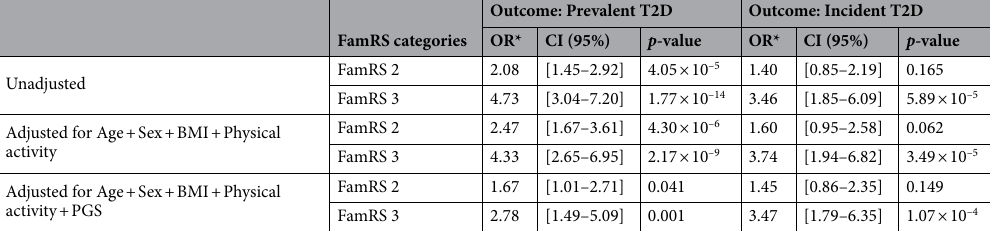
Table 4. Results of Logistic regression models of the effect of FamRS on risk of prevalent and incident diabetes *ORs are given for FamRS categories “positive and strong positive family risk” (FamRS 2) and “very strong positive family risk” (FamRS 3) compared to average family